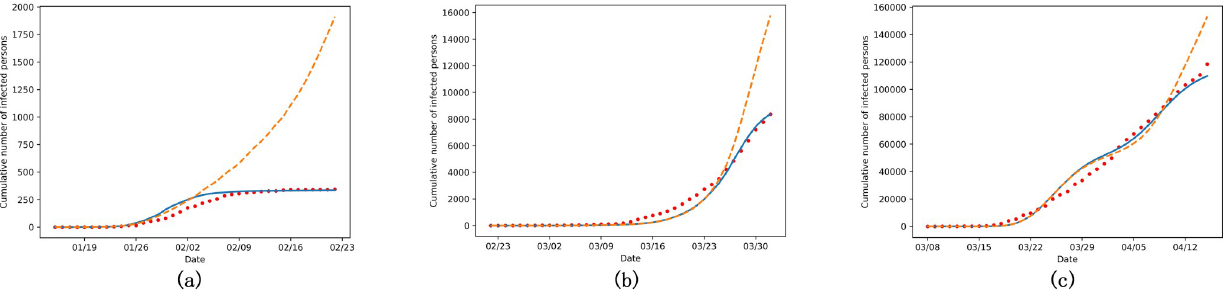
Fig 4. The suppression effect of emotional contagion. (a) Guangzhou, China, (b) London, the UK and (c) New York, the US. The solid lines denote simulation results with the emotional contagion layer and the dotted lines denote results without the emotional contagion layer. Red circles denote the actual